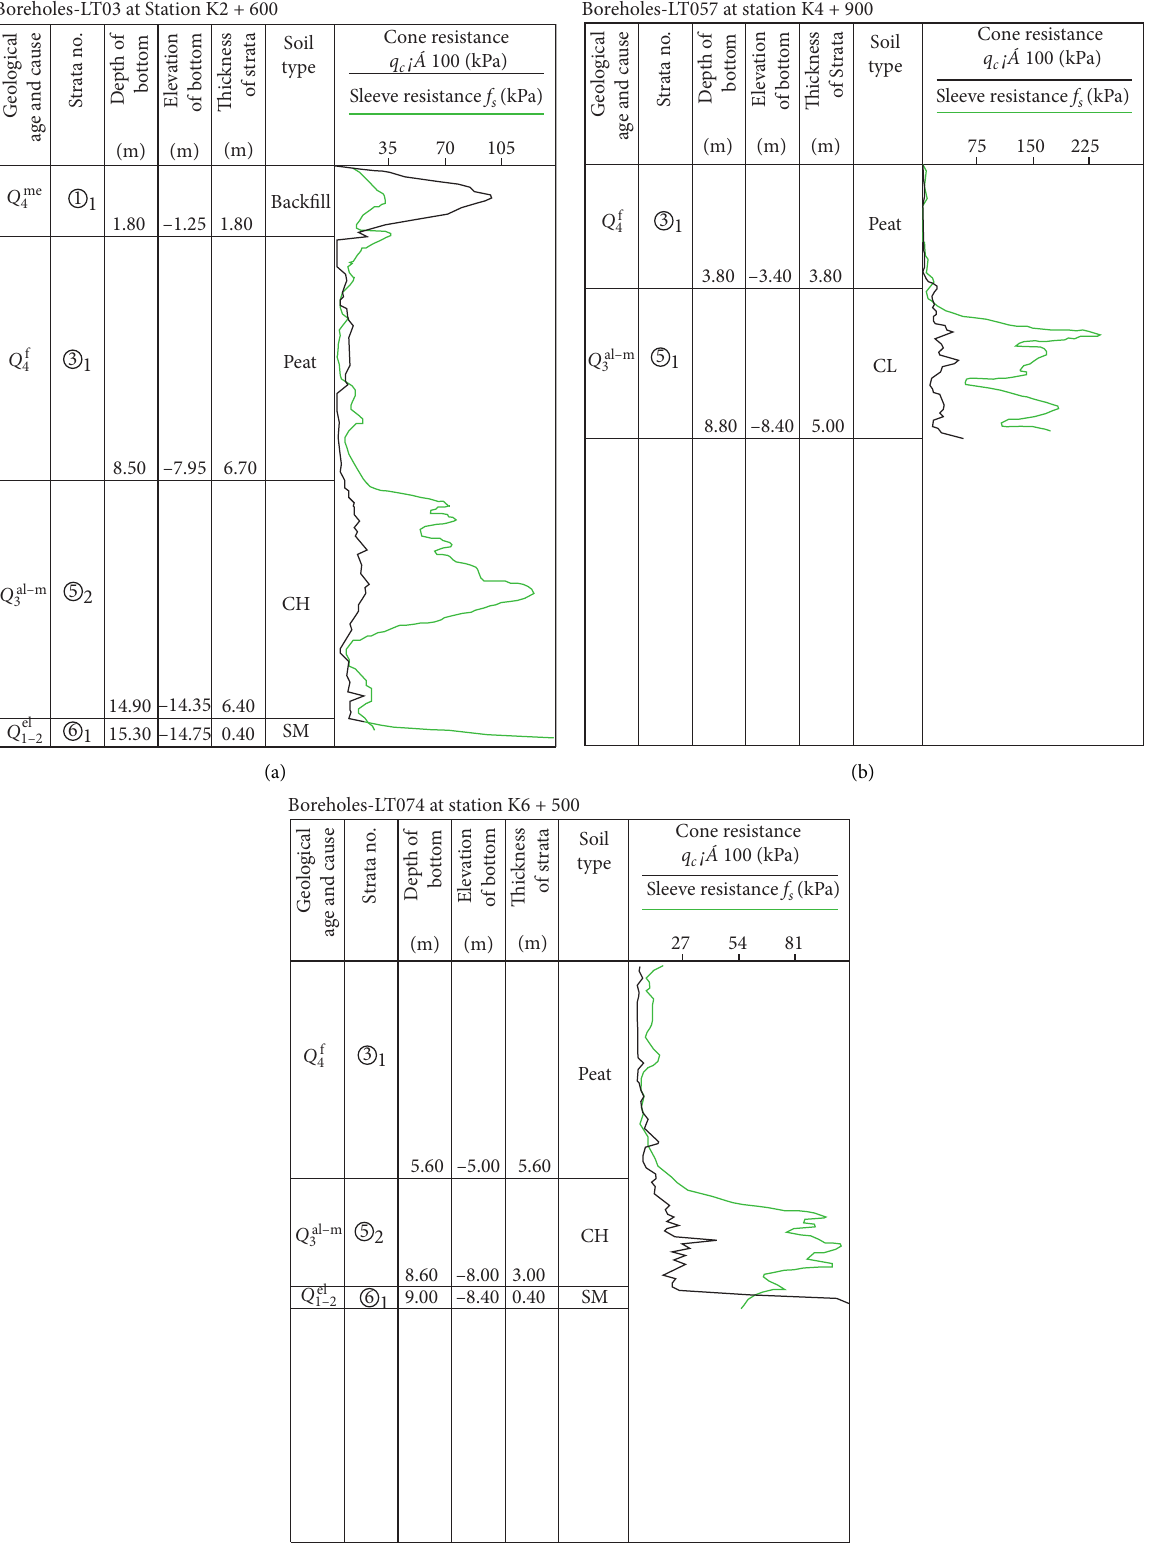
Figure 3: CPT on the section of (a) K2 +600, (b) K4 +900, and (c)